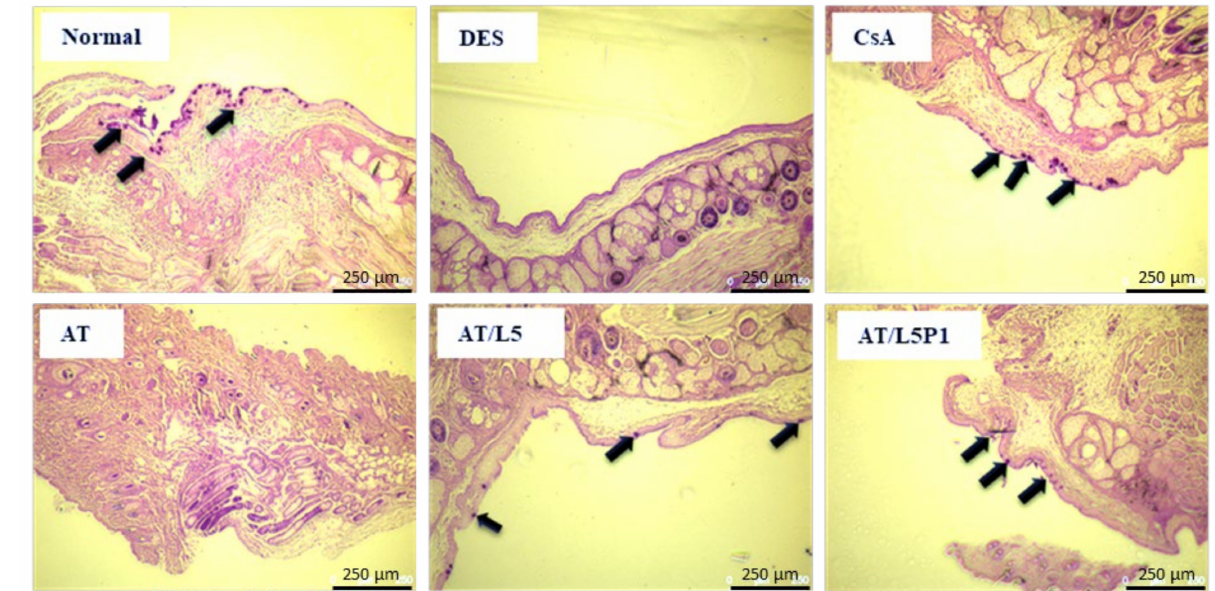
Figure 8. Microphotograph of conjunctival goblet cells followed by PAS staining of the eye sections from BAC-induced DES mice in variant groups (Scale bar = 250 µ m). The arrows indicate the goblet